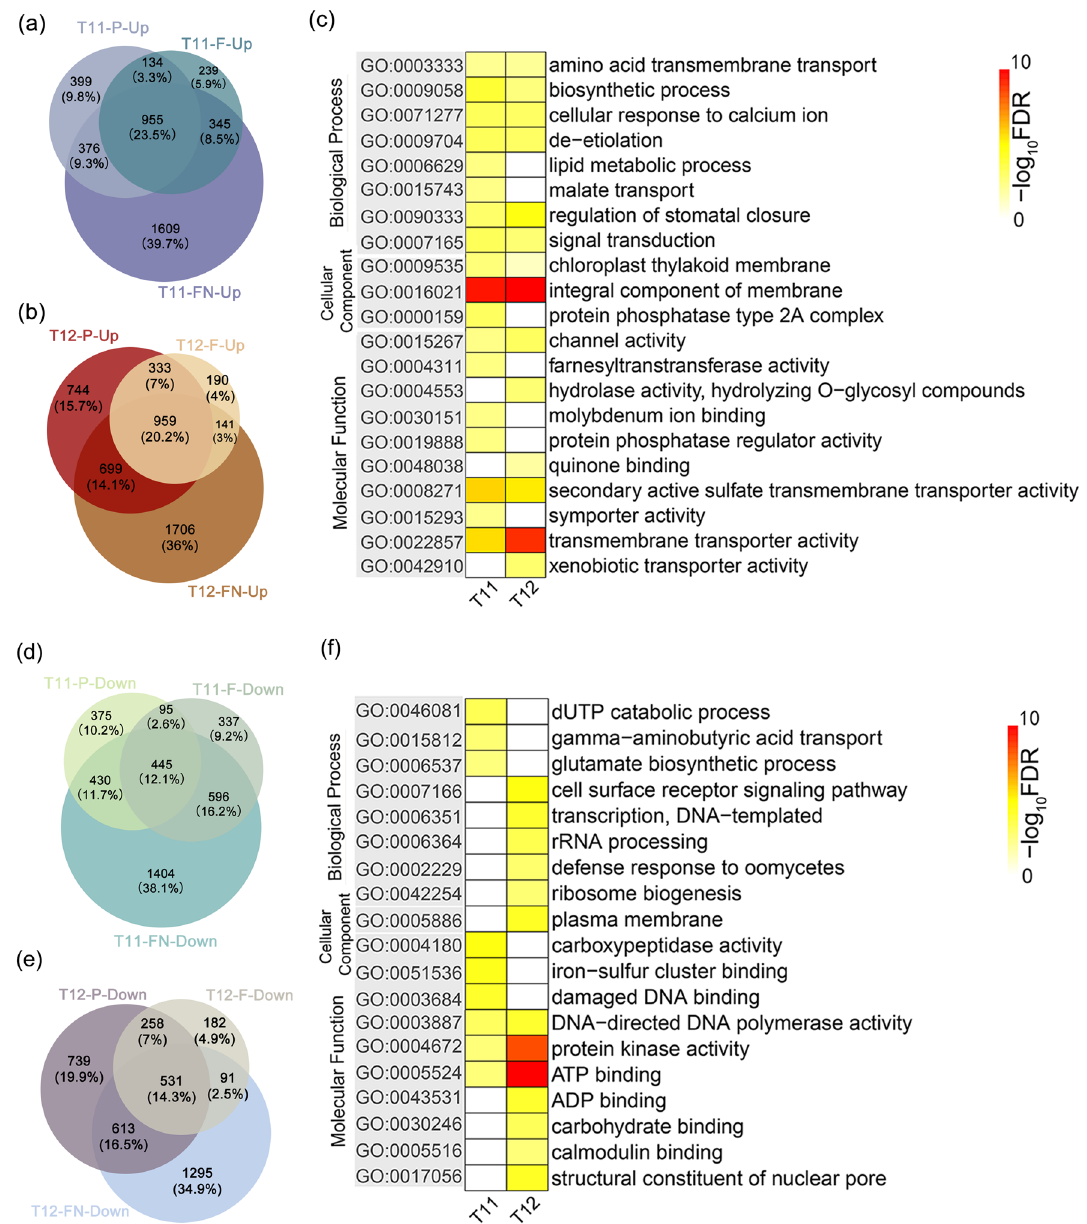
Fig. 4 GO enrichment analysis of DEGs. a and b The venn diagrams of the upregulated genes of T11 (T11-P, T11-F and T11-FN) and T12 (T12-P, T12-F and T12-FN), respectively. c Heatmap of GO enrichment analysis of upregulated overlapped genes of T11 (overlapped T11-P and T11-F) and T12 (overlapped T12-P and T12-F). d and e The venn diagrams of the downregulated genes of T11 (T11-P, T11-F and T11-FN) and T12 (T12-P, T12-F and T12-FN), respectively. f Heatmap of GO enrichment analysis of downregulated overlapped genes of T11 (overlapped T11-P and T11-F) and T12 (overlapped T12-P and